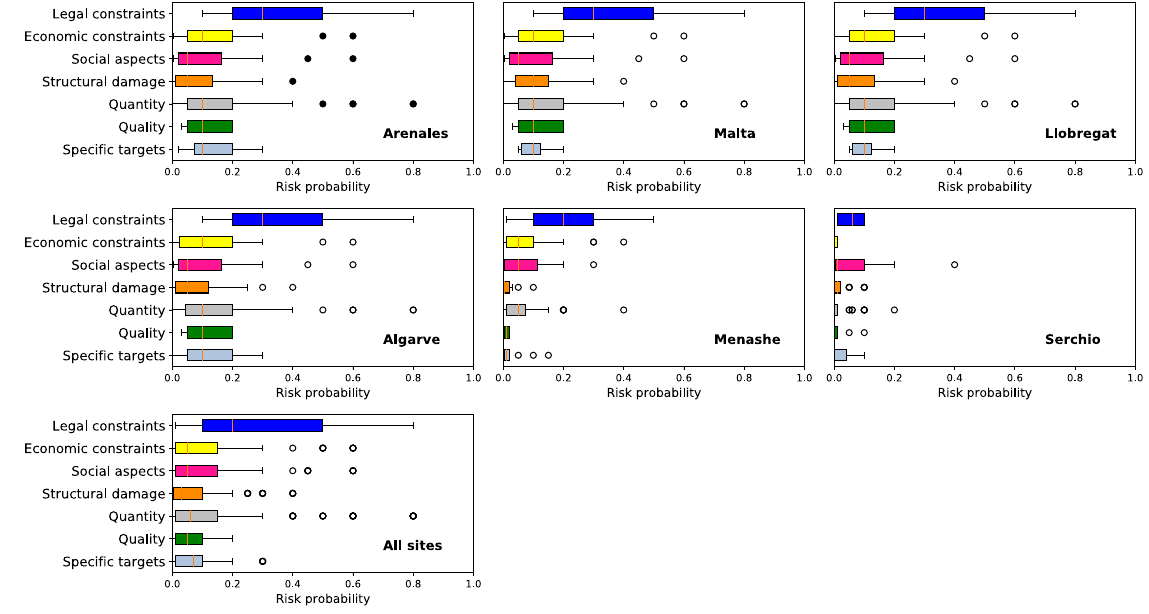
Figure 5. Distribution of the expert criteria by category and for the three levels (low, medium, high) grouped by